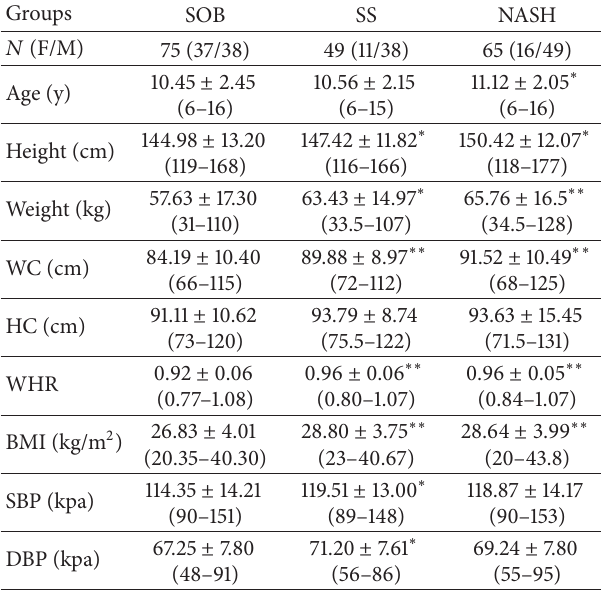
Table 1: Comparison of anthropometric